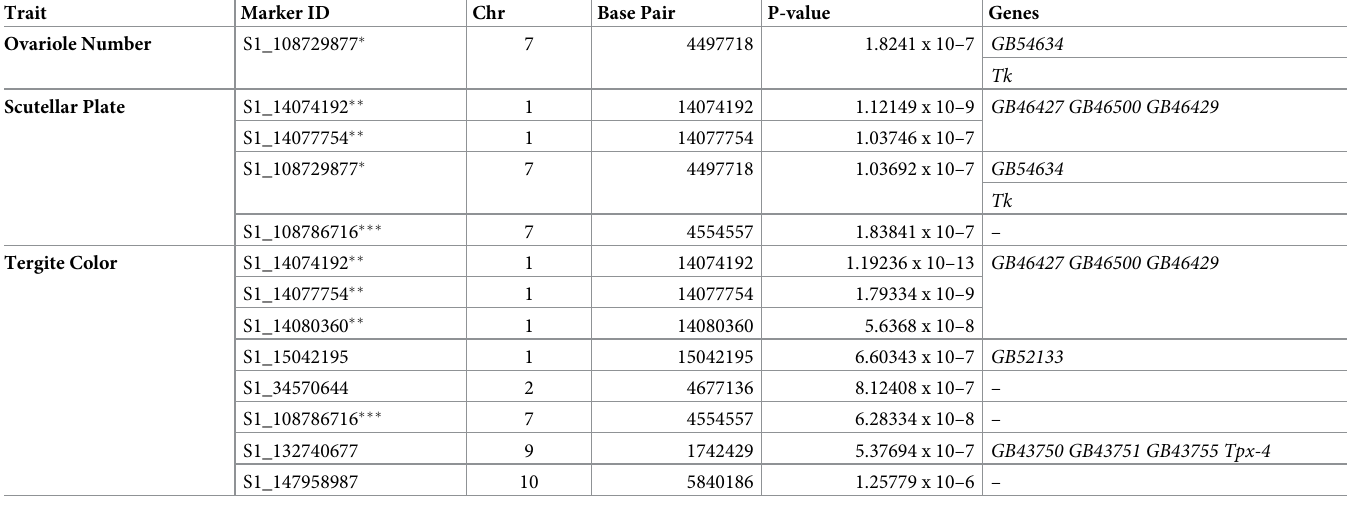
Table 1. Genome wide association study traits, significant markers, respective chromosome (Chr) location, number of base pairs, statistical information, and within region/nearby annotated genes.